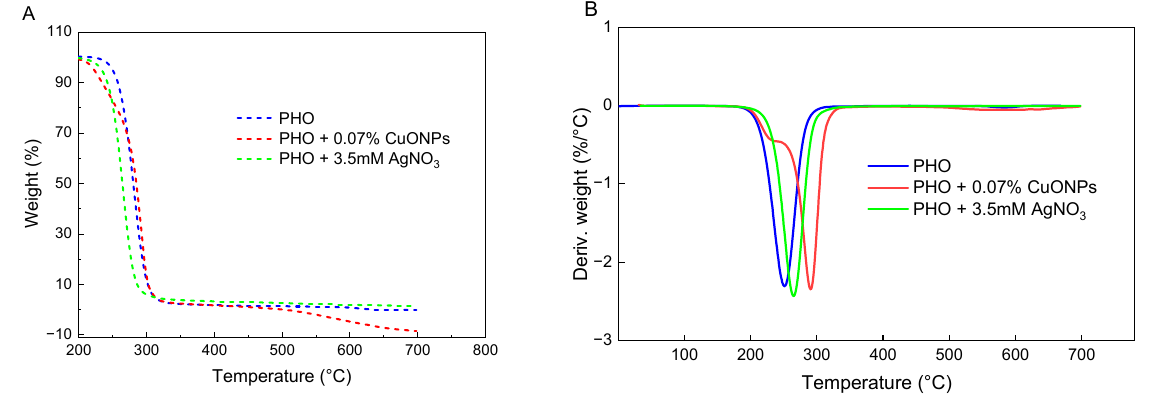
Figure 4. Thermal stability and degradation of active PHO films with a heating rate of 10 °C min − 1 ( A ): weight loss (%), and ( B ): the first derivative of the weight loss curve (%/ °C).